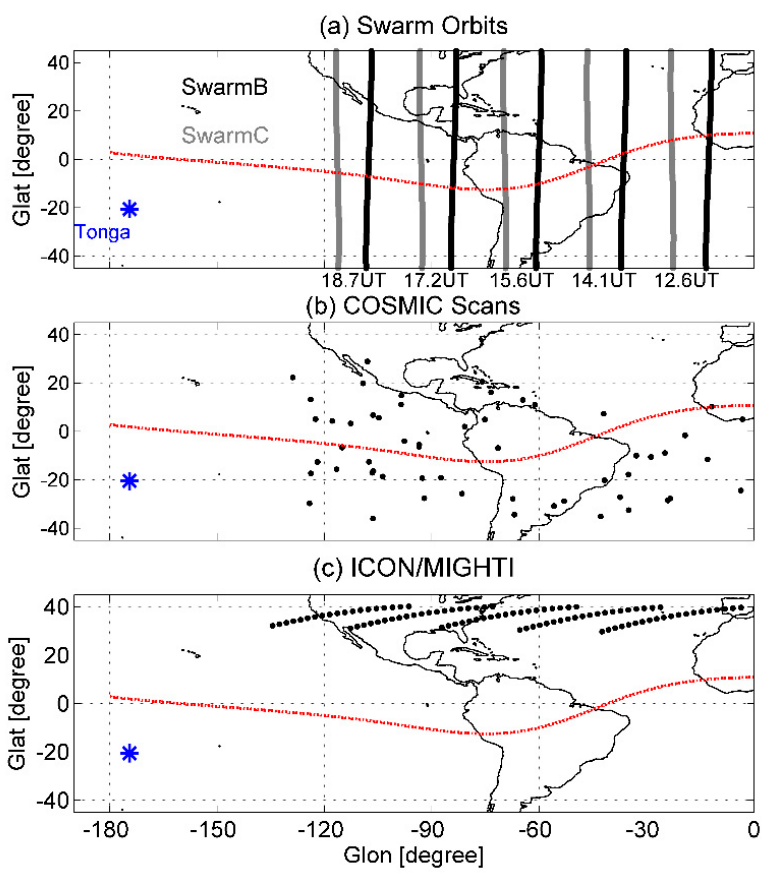
Figure 1. The orbits of ( a ) Swarm B and C, ( b ) COSMIC, and ( c ) ICON/MIGHTI satellites at low latitudes on 15 January 2022. The orbits of Swarm B and C are given in black and gray bold lines, respectively. The COSMIC and ICON/MIGHTI are given in black dots. The blue star is the geographic location of the Tonga volcano. The red dotted line is the geomagnetic equator.